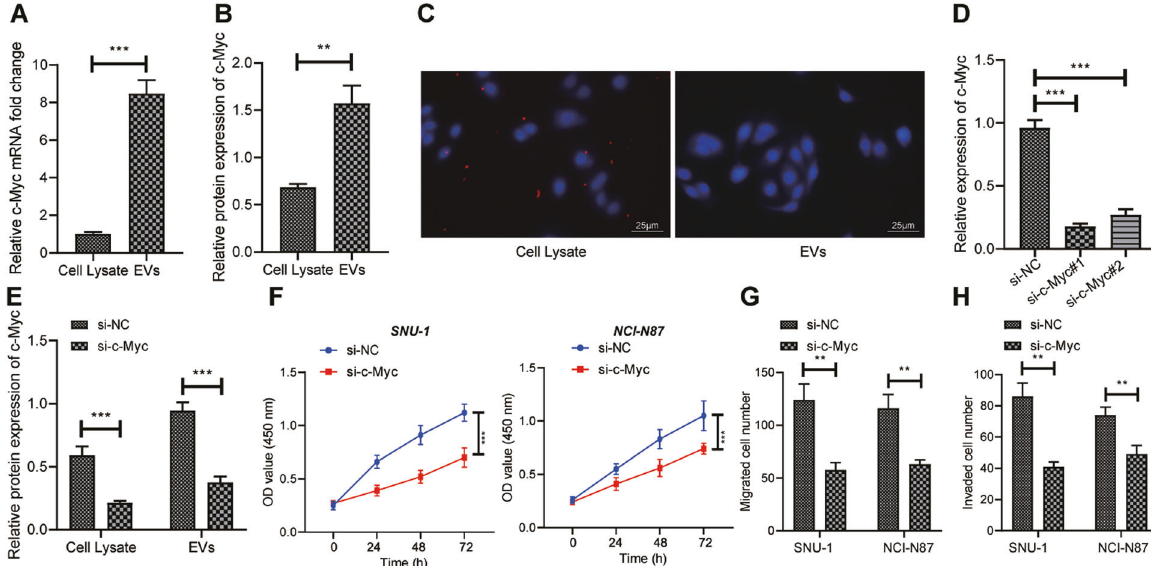
Fig. 3 EVs-c-Myc accelerates proliferation, migration, and invasion of GC cells. A RT-qPCR was used to detect the mRNA expression of c-Myc in GC cells and EVs. B The protein expression of c-Myc in GC cells and EVs determined by Western blot analysis. C The expression of Flag-c-Myc in GC cells detected by immuno fl uorescence (Flag labeling was red fl uorescence, DAPI labeling was blue fl uorescence; scale bar: 50 μ m). D Detection of knockdown ef fi ciency of two si-c-Myc sequences by RT-qPCR. E Western blot analysis was used to detect the protein expression of c-Myc in SNU-1 cells and EVs after knockdown of c-Myc. F CCK-8 was used to check the proliferation of SNU-1 and NCI-N87 cells after knockdown of c-Myc in EVs. G Transwell assay was used to test the migration of SNU-1 and NCI-N87 cells after incubation with EVs from GC cells with knockdown of c-Myc. H The invasion of SNU-1 and NCI-N87 cells after incubation with EVs from GC cells with knockdown of c-Myc detected by Transwell assay. * represents the comparison between the two groups. * p < 0.05; ** p < 0.01. The cell experiment was repeated 3